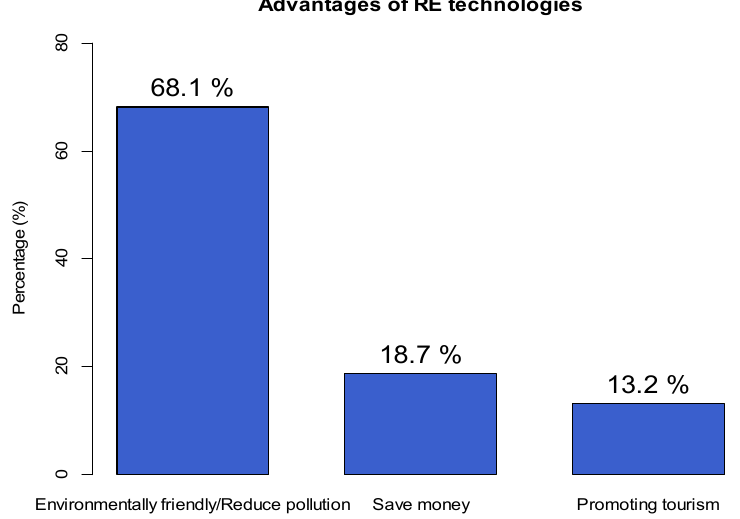
Figure 14. Response of the participants on the benefits of RE (wind and solar) technologies.